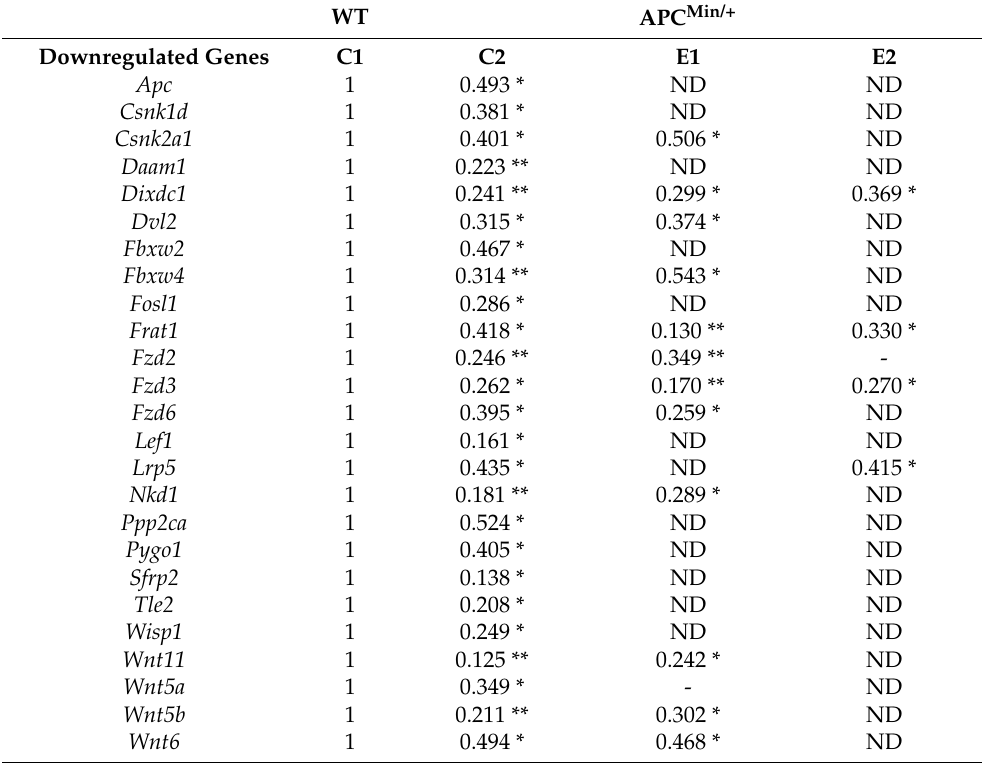
Table 6. Fold change in the expression level of genes of the WNT signaling pathway downregulated in APC Min/+ mice fed either with a standard diet (C2 group) or with a supplemented diet (E1 and E2 groups) as compared to wild-type mice fed with a standard diet (C1 group). WT APC Min/+